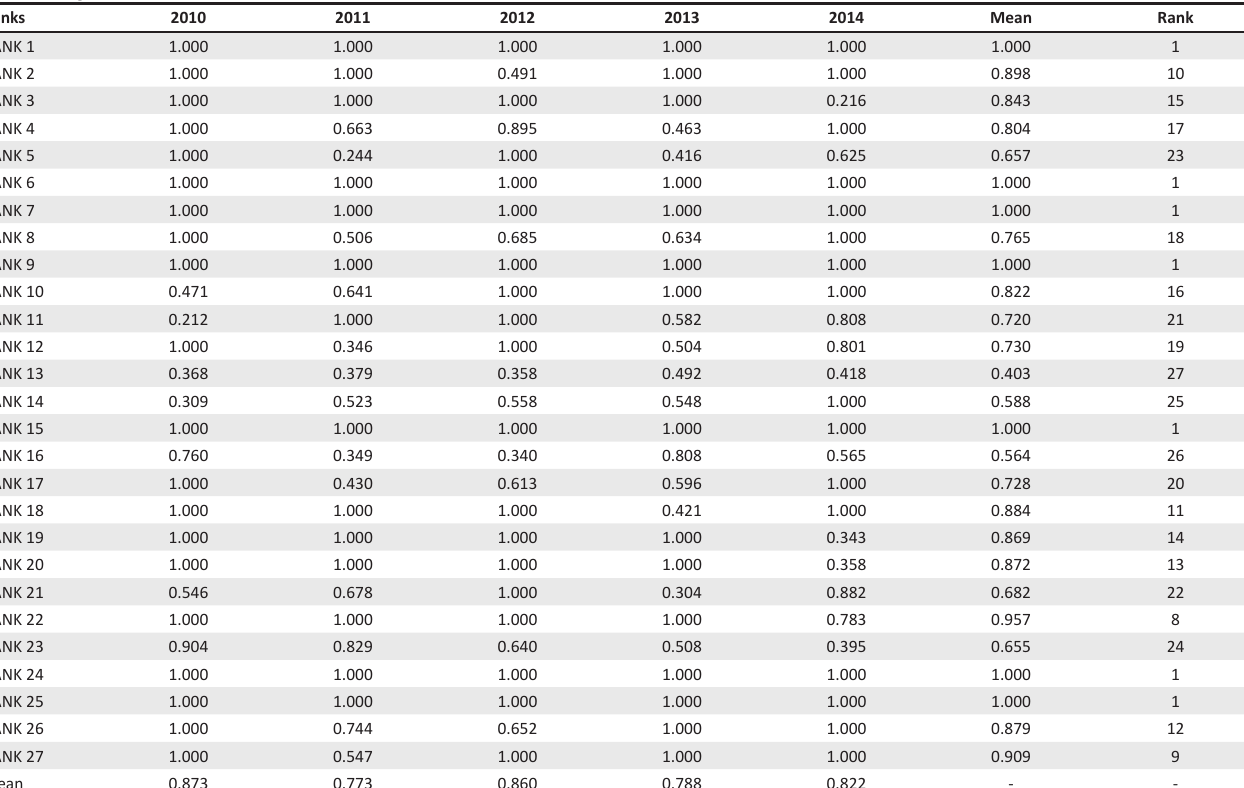
TABLE 4: Stage 2 efficiencies.